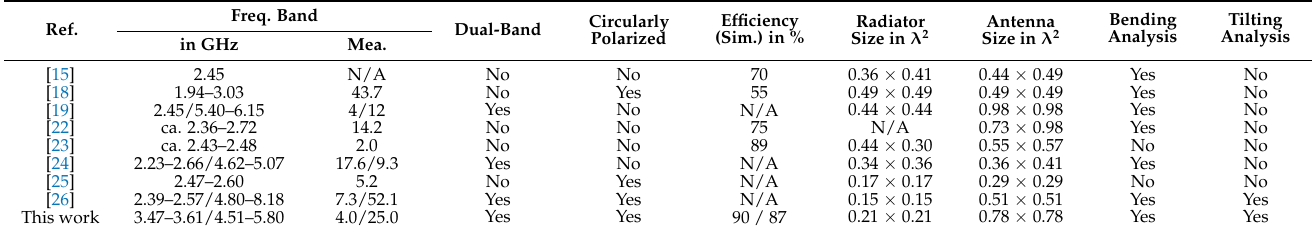
Figure 19. SAR of the proposed antenna ( a ) at 3.55 GHz, and ( b ) at 5.5 GHz. Table 2 gives a comparison of wearable antennas for wireless power transfer in literature. The superiority of the proposed antenna sensor is clearly shown. The designed polarized radiation, a very small radiator size, and high efficiency. Table 2. Comparison of wearable antennas for wireless power